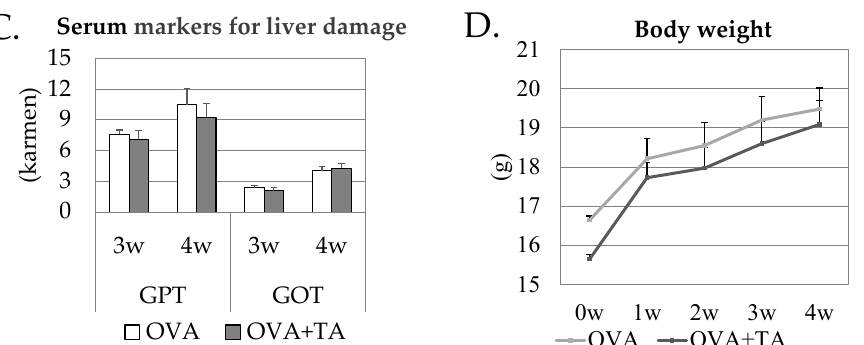
Figure 2. Serum parameters of mice at 3 w and 4 w in OVA and OVA + TA groups. ( A ) Serum glucose, triglyceride, and total cholesterol concentrations. ( B ) total proteins and serum albumin concentrations. ( C ) serum glutamic-pyruvic transaminase (GTP) and glutamic-oxaloacetic transaminase (GOT) activity of each mouse group at 3 w and 4 w. ( D ) Body weight changes of each mouse group from 0 w to 4 w. All data are expressed as mean ± standard deviation; OVA group ( n = 6), OVA + TA group ( n = 6). * p < 0.05.